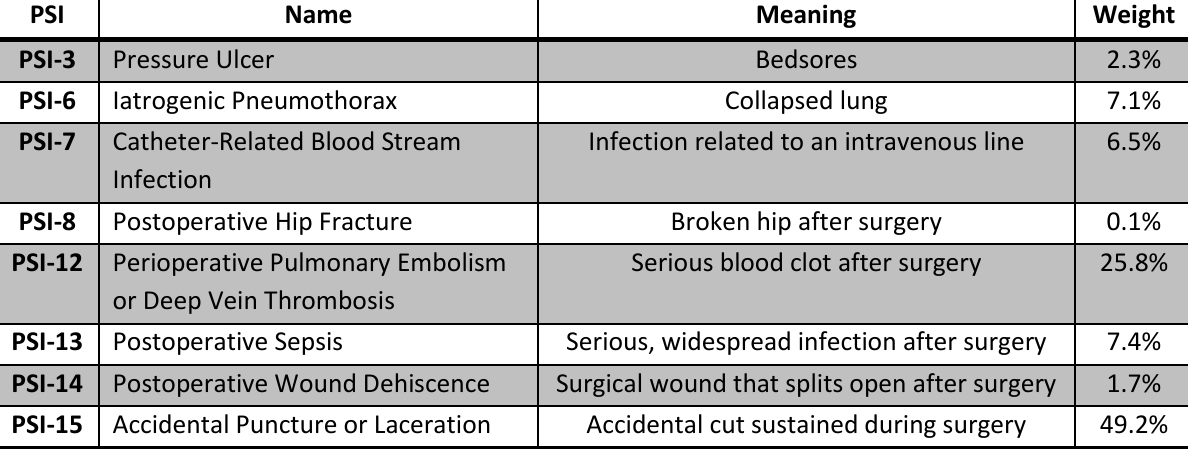
Table 6.2: Patient Safety Indicators and Composite Measure Weights (PSI-90 version